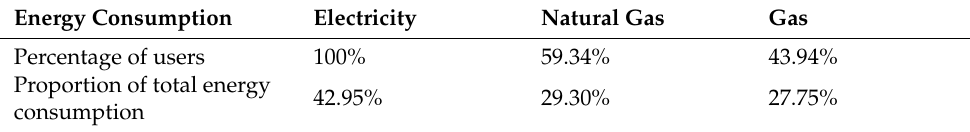
Table 4. Household energy consumption by energy source.